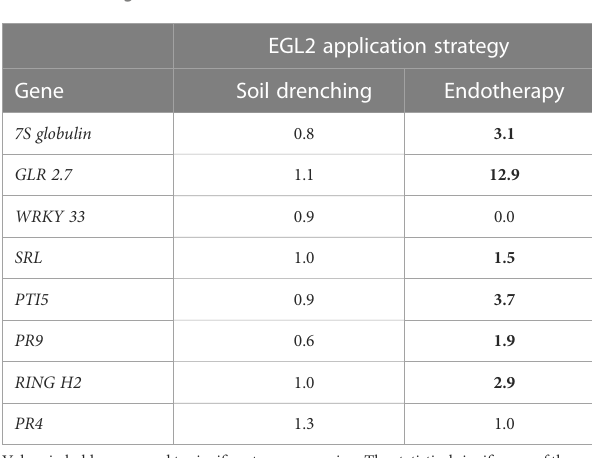
TABLE 2 Expression of genes related to plant defense response in Prunus dulcis after Eucalyptus essential oil treatments, applied by two different strategies.